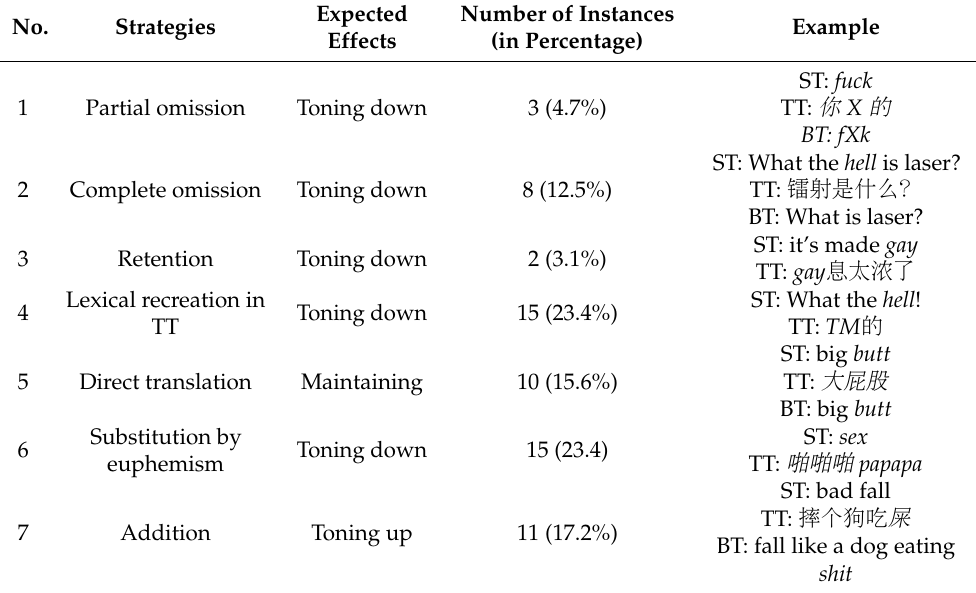
Table 4. Results I.